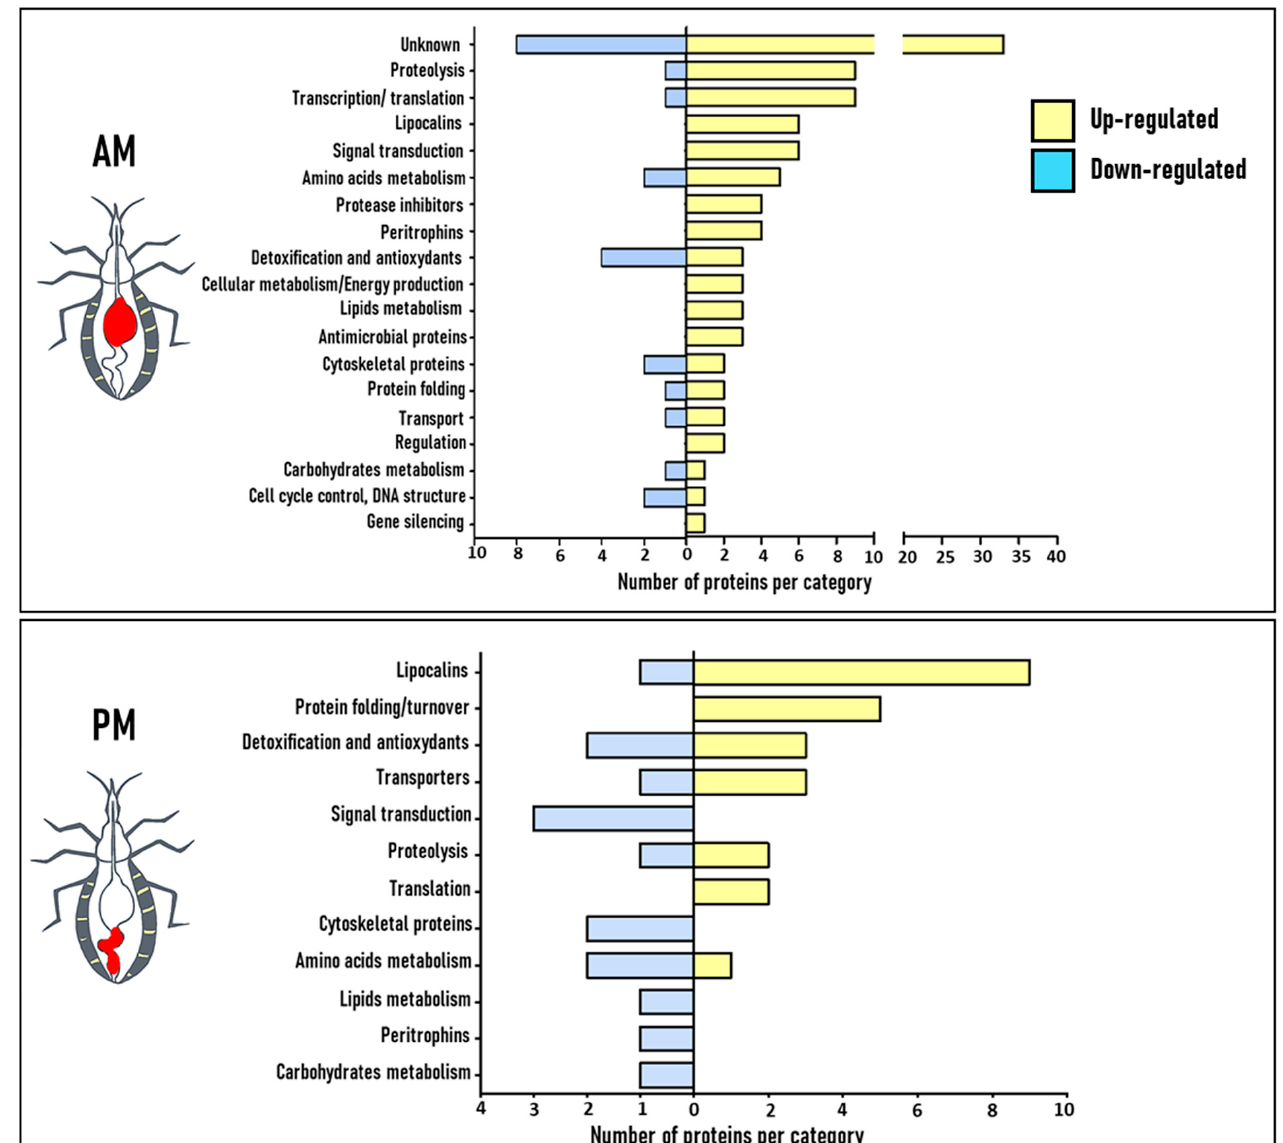
Figure 2. Functional annotation of differentially expressed proteins between starved and blood fed conditions in R. prolixus AM (upper panel) and PM (lower panel) tissues. The proteins have been classified according to their physiological and/or cellular function according to Gene Ontology and the literature. Table S1 provides details on Gene Ontology (GO) analysis and classification.